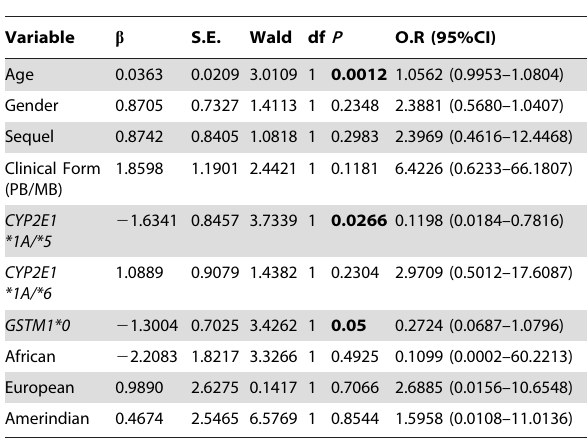
Table 4. Logistic regression analysis of the association between genetic markers and LBI/HBI response in leprosy